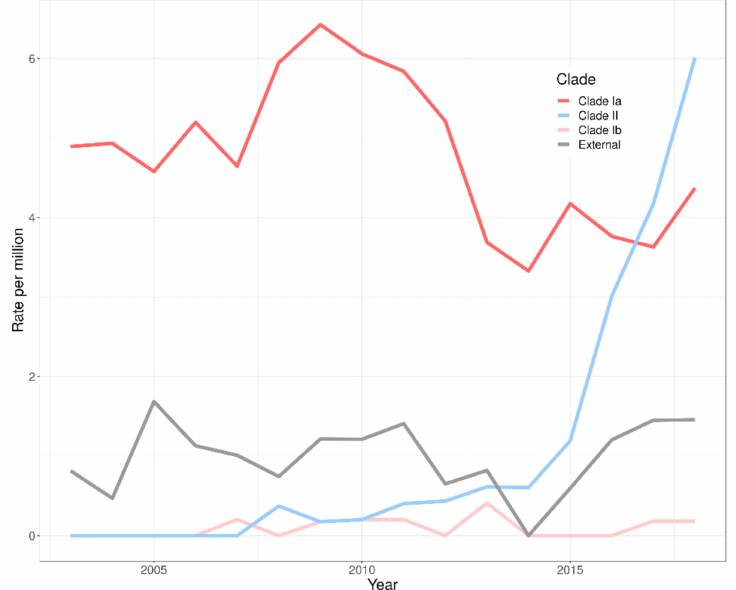
Figure 3. Time trend analysis for the S. pneumoniae serotype 3 clade groups over time. The rate is estimated per million people and shows a significant increase in clade II from 2013 and a slight decrease in clade Ia over the